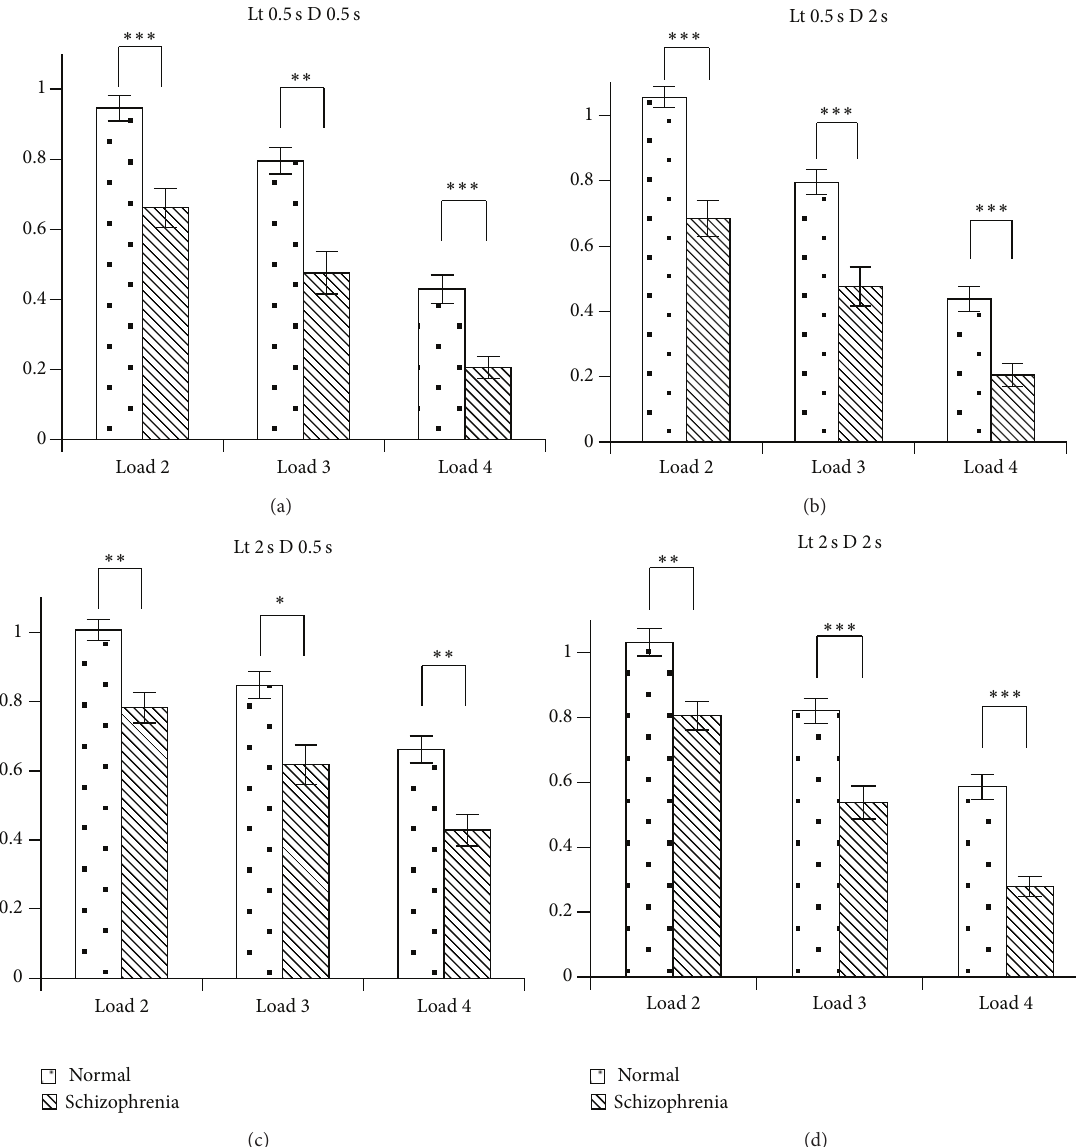
Figure 3: Comparative results of SZ20s and 20 s age groups. a–d show the accuracy per second of SZ20s and 20s age groups, at the different loads of difficulty with combinations of different learning time and delay span. ∗ 𝑃 < 0.05 ; ∗∗ 𝑃 < 0.01 ; ∗∗∗ 𝑃 < 0.0001